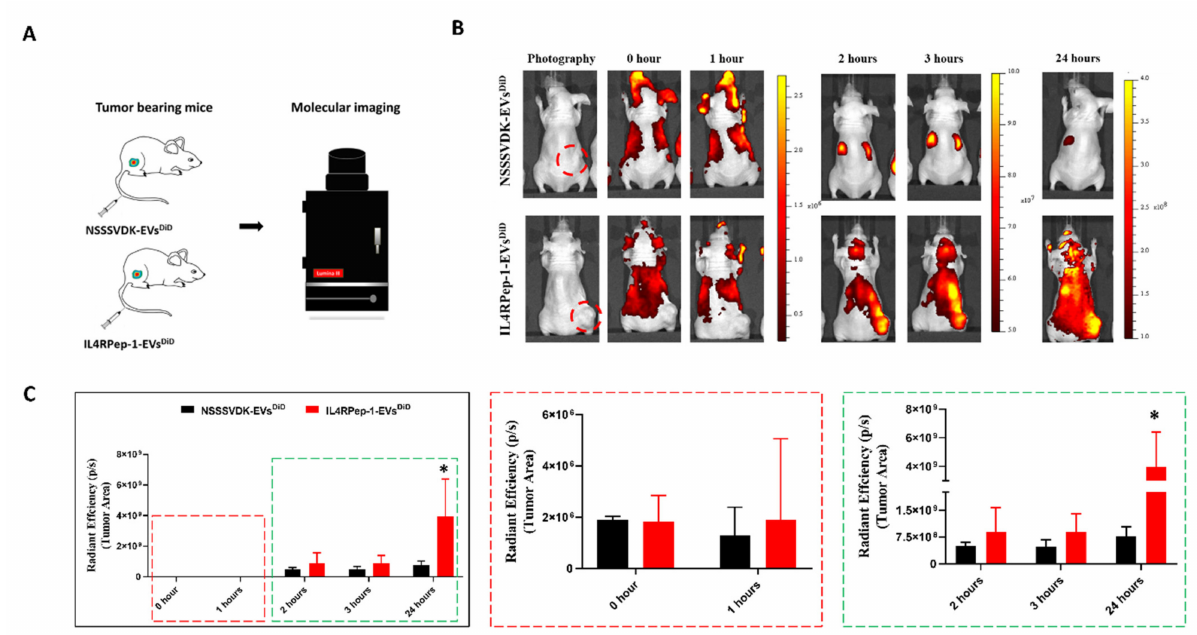
Figure 6. Intravenously (i.v.) injected IL4RPep-1 extracellular vesicles (EVs) target Cal-62 tumors in mice, as shown by fluorescent imaging. ( A ) Schematic image of Cal-62 tumor-bearing mouse after i.v. injection of NSSSVDK-EV DiD or IL4RPep-1-EV DiD (50 µ g of EVs) using IVIS imaging system. ( B ) Florescent imaging at 0 h, 1 h, 2 h, 3 h, and 24 h after i.v. injection of NSSSVDK-EV DiD or IL4RPep-1-EV DiD in Cal-62 tumor-bearing mice (n = 3). ( C ) Quantification of florescent signals at the tumor region. Data are represented as means ± standard deviations (SD). Statistical differences between groups were analyzed using Student’s t -test. * p <